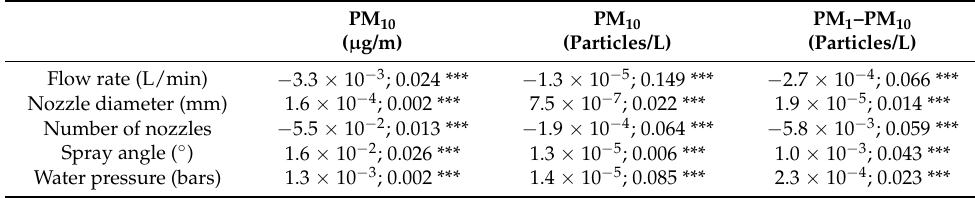
Table 2. Multivariable regression results (Coef; R 2 ) illustrating the influences of major showerhead characteristics on the PM fractions generated during showering in the presence or absence of a